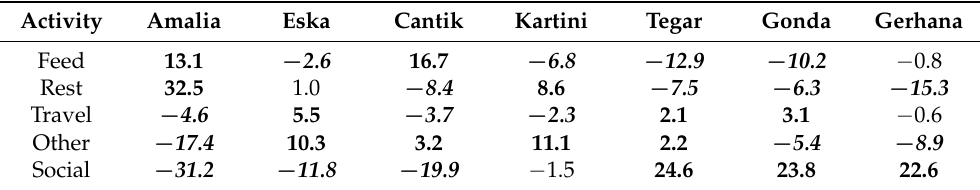
Table 3. Inter-individual comparison of the activity